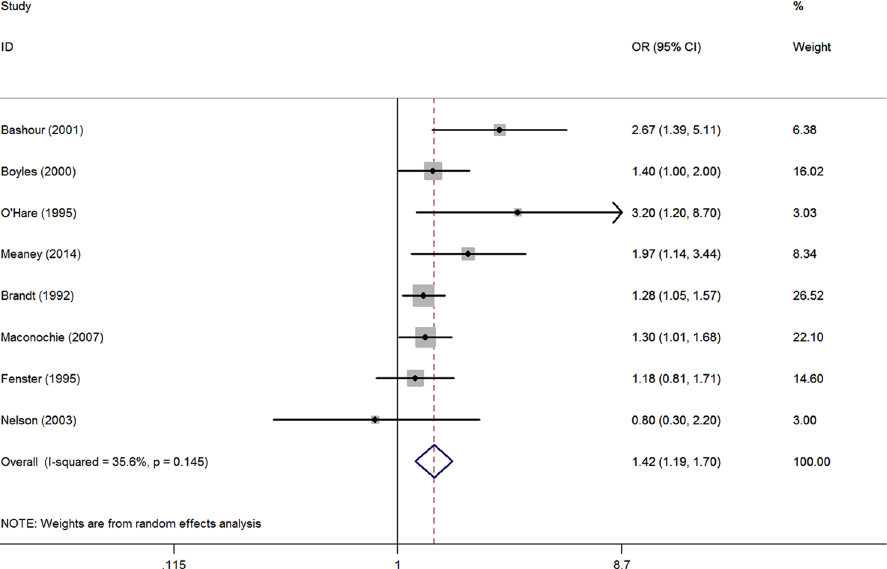
Figure 2. Meta-analysis of eight studies about the effect of maternal psychological stress on miscarriage. (note: OR, odds ratio; CI, confidence interval).